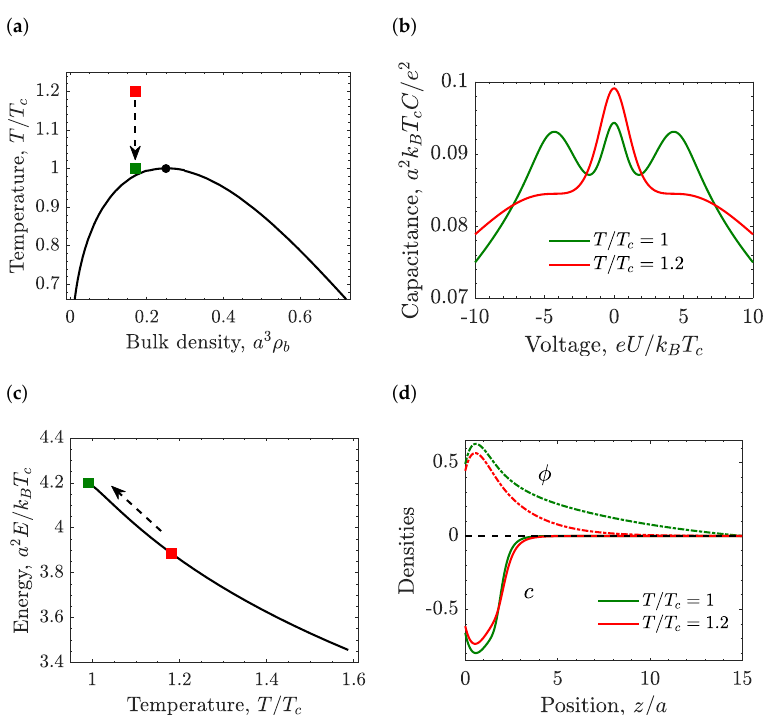
Figure 6. Differential capacitance close to demixing for the Carnahan–Starling (CS) approximation. ( a ) Bulk phase diagram in the temperature-bulk density plane showing the temperatures used in the following panels. The red square denotes T / T c = 1.2, whereas the green square represents T / T c = 1. ( b ) Differential capacitance as a function of applied potential at constant bulk density ρ b = 0.17, ionophilicity ¯ h s = a 3 h s / ξ 0 = 0.08, and two different temperatures, demonstrating the bell-shaped capacitance for T / T c = 1.2 and the bird-shaped capacitance for T / T c = 1. ( c ) Stored energy as a function of temperature. ( d ) Density profiles. Order parameter φ = a 3 ( ρ − ρ b ) (dashed lines), where ρ = ρ + + ρ − is the ion density, and the charge density c = a 3 ( ρ − ρ b ) (solid lines) calculated at T / T c = 1 (green lines) and T / T c = 1.2 (red lines) marked by colored squares in the previous panel. The bulk density ρ b = 0.17, voltage eU / k B T c = 20, and ionophilicity ¯ h s = a 3 h s / ξ 0 = 0.08. For common values of the ion diameter a = 0.7nm and room temperature for T c , the various units are: thermal voltage e / k B T c ≈ 26mV for voltage, thermal electric capacitance e 2 / ( k B T c a 2 ) ≈ 620µFcm − 2 for